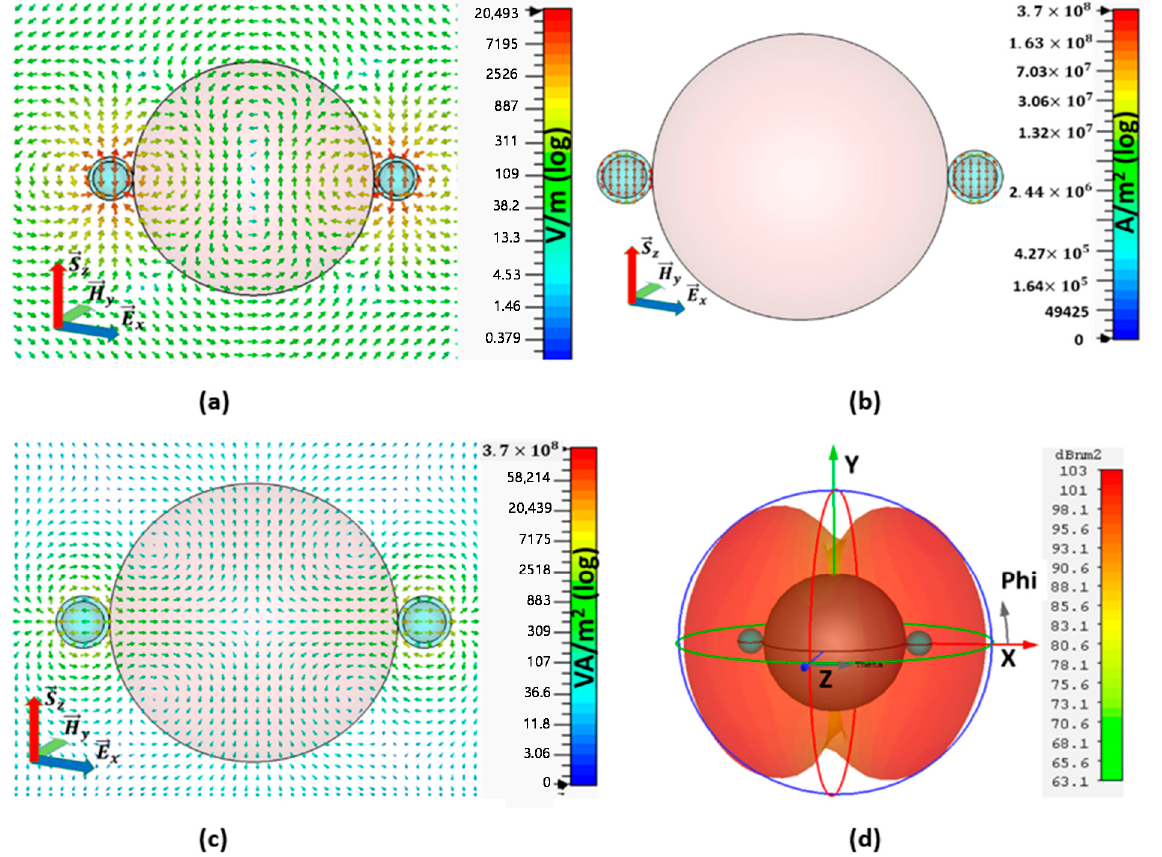
Figure 5. Field distribution of A-CNPs configuration II with maximum SCS peak at f = 599.9953 THz: ( a ) electric field distribution for Configuration II. ( b ) current density distribution. ( c ) power flow and ( d ) far-field pattern for configuration II at the resonance frequency.